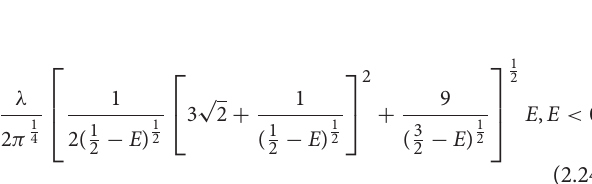
FIGURE 1 | Approximating potentials V n ( x , y ) (pink), 30 (magenta), and 70 (cyan).